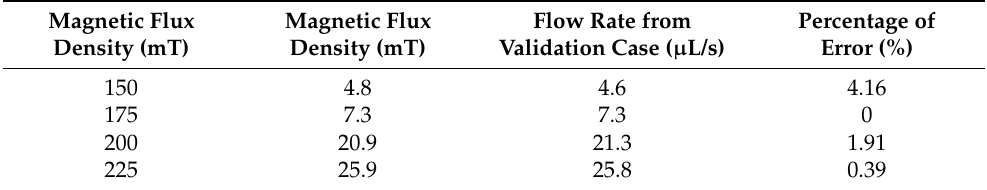
Figure 8. Net pumped volume comparisons between this study and benchmark study “Reprinted/adapted with permission from Ref. [18]. 2022, Rubayet Hassan”. Table 5. Percent error of the flow rates between this study and benchmark study “Reprinted/adapted with permission from Ref. [18]. 2022, Rubayet Hassan” .